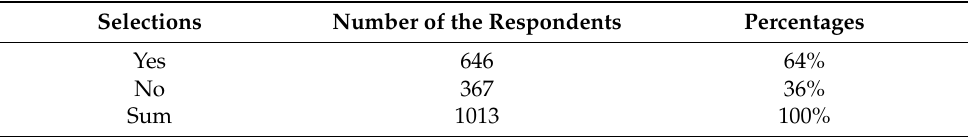
Table A14. Is it necessary to add new projects to current IFRS standards for holdings of cryptocurren- cies (single-choice